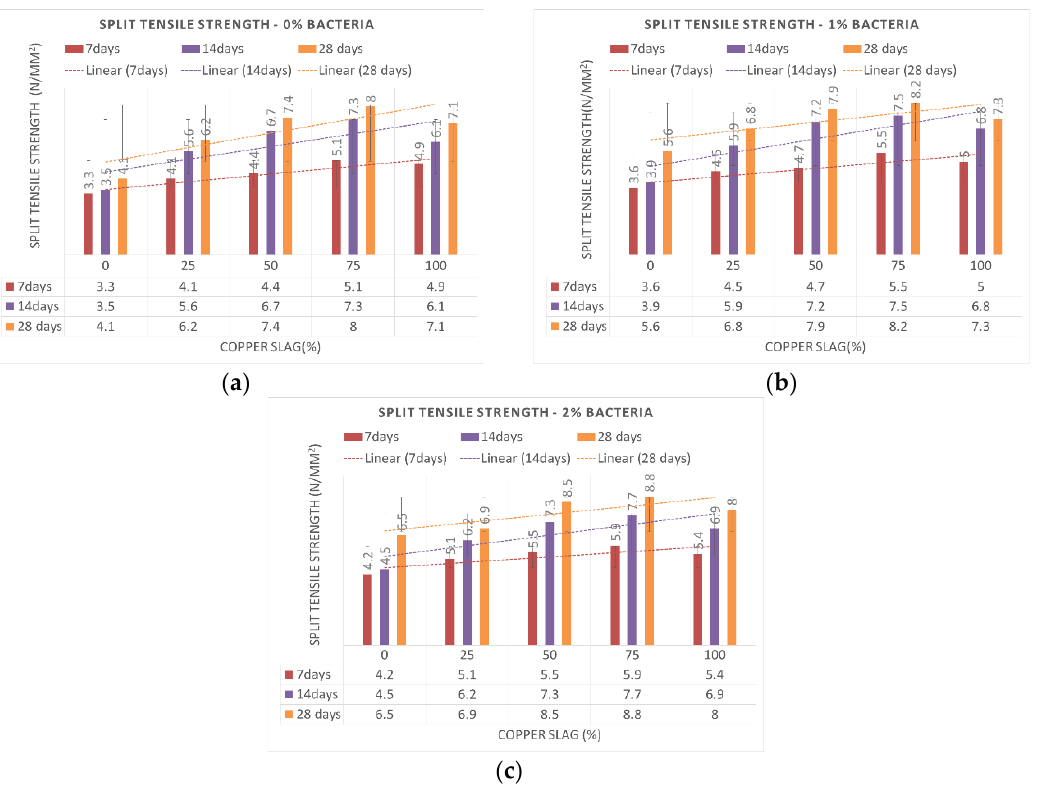
Figure 13. Split tensile strength of copper slag concrete with micro-organisms. ( a ) 0% bacteria. ( b ) 1% bacteria. ( c ) 2% bacteria.